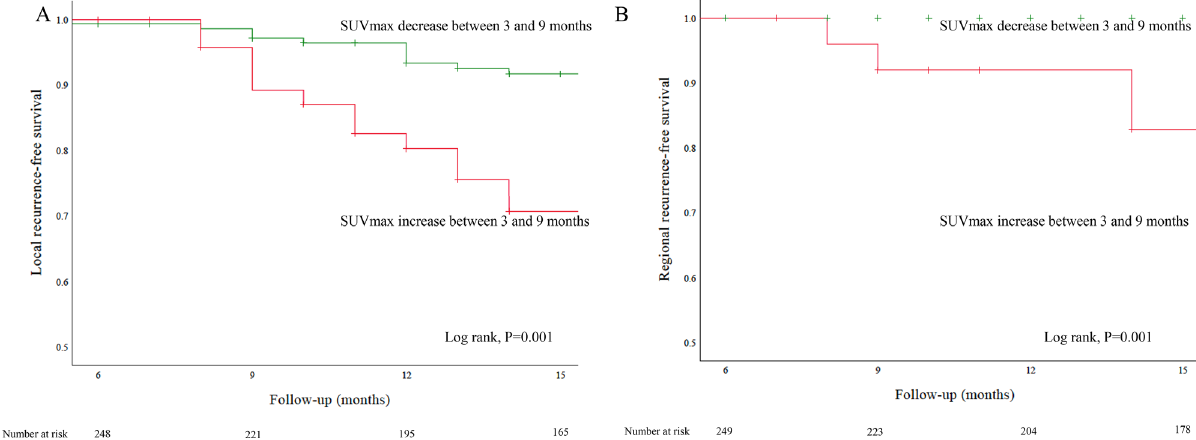
Figure 5. Kaplan–Meier analysis showing local recurrence-free ( A ) and regional recurrence-free survival ( B ) in patients according to tumor site. Both relative recurrence-free survivals were different in a statistically highly significant manner (Log rank, P = 0.001, for